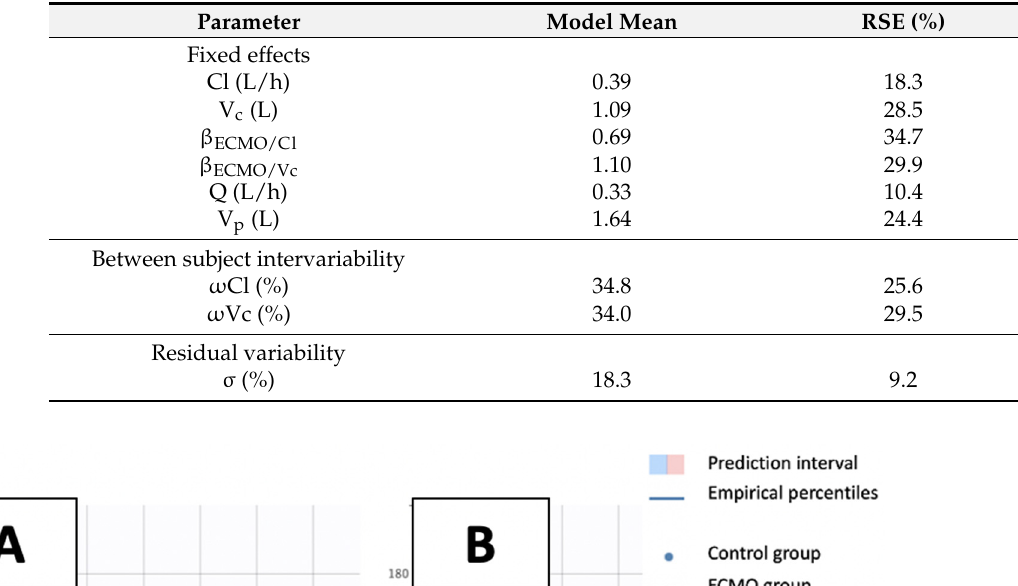
Table 3. Estimated population parameters for amiodarone using a modeling approach. Between- Subject Variability (BSV) expressed as the coefficient of variation of the associated non-log- transformed parameter, clearance (Cl), central distribution volume (V c ), peripheric compartment (V p ), relative standard error (RSE) (standard error of the estimate divided by the estimate and multiplied by 100), impact of ECMO on clearance ( β ECMO/Cl ), impact of ECMO on central distribution volume ( β ECMO/Vc ), ω , coefficient of variation for between-subject variability; σ , parameters of error model.